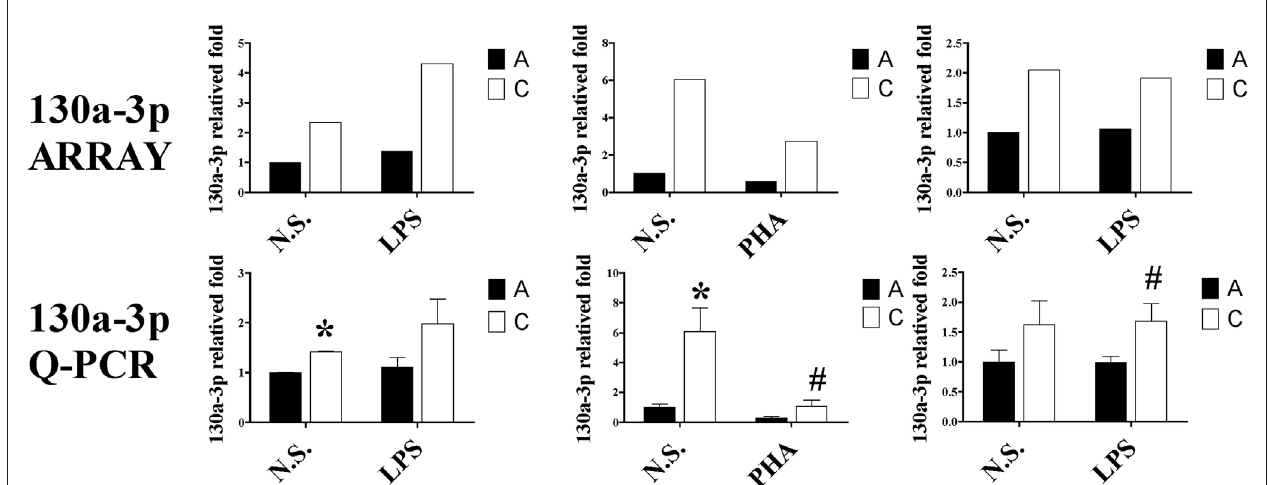
FigUre 11 | continued To validate the data derived from our microarray analysis and literature references, we subjected RNA extracts harvested from stimulated or unstimulated polymorphonuclear cell, CD4 + T cells, and CD14 + monocytes of neonatal and adult samples for qRT-PCR analysis of let-7b-5p, miR-29a-3p, miR-29b-3p, and miR-130a-3p expression * p < 0.05 between indicated adult and CB leukocytes without stimulation; # p < 0.05 between indicated adult and CB leukocytes with stimulation; § p < 0.05 between indicated CB leukocytes without and with stimulation (by ANOVA with the LSD post hoc test, n =